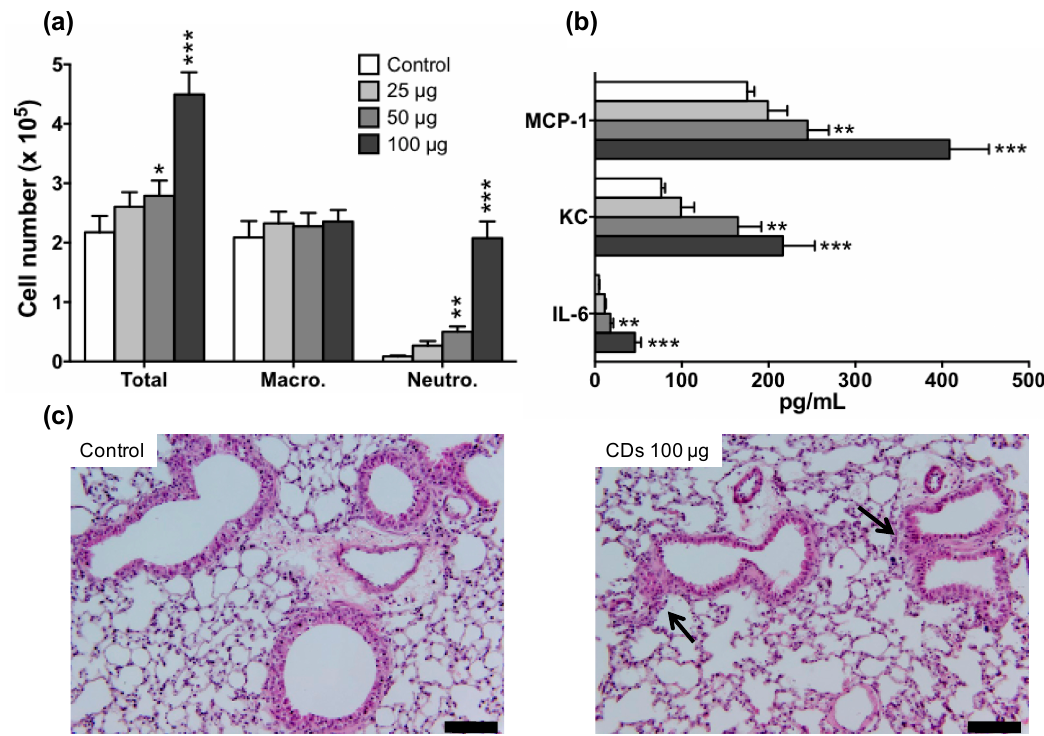
Figure 2 . Lung inflammation induced by CDs in mice. Mice received a single administration of 25, 50 or 100 µg of CDs, and airway inflammation was assessed 24 h later. ( a ) Total and differential cell counts and ( b ) proinflammatory cytokines in BALFs. Data are means ± SEM of n = 6 mice. Statistical differences when compared to controls were determined by ANOVA followed by the Dunnett’s test. * p < 0.05; ** p < 0.01; *** p < 0.001. ( c ) Histopathology of lung tissues from control mice (left) or mice exposed to 100 µg CDs (right). Lung sections were stained with hematoxylin and eosin (scale bar = 50 µm; black arrow: cell infiltrate).